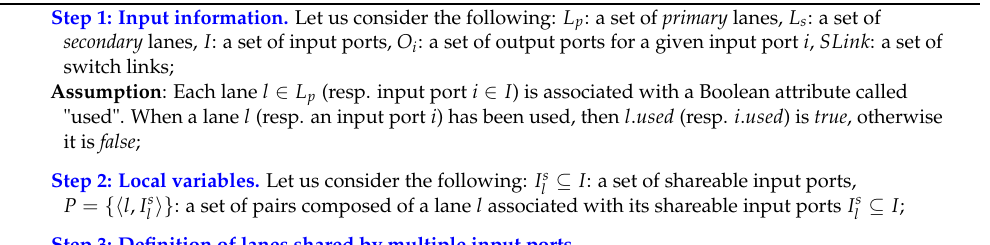
Algorithm 1: R-NoC topology generation